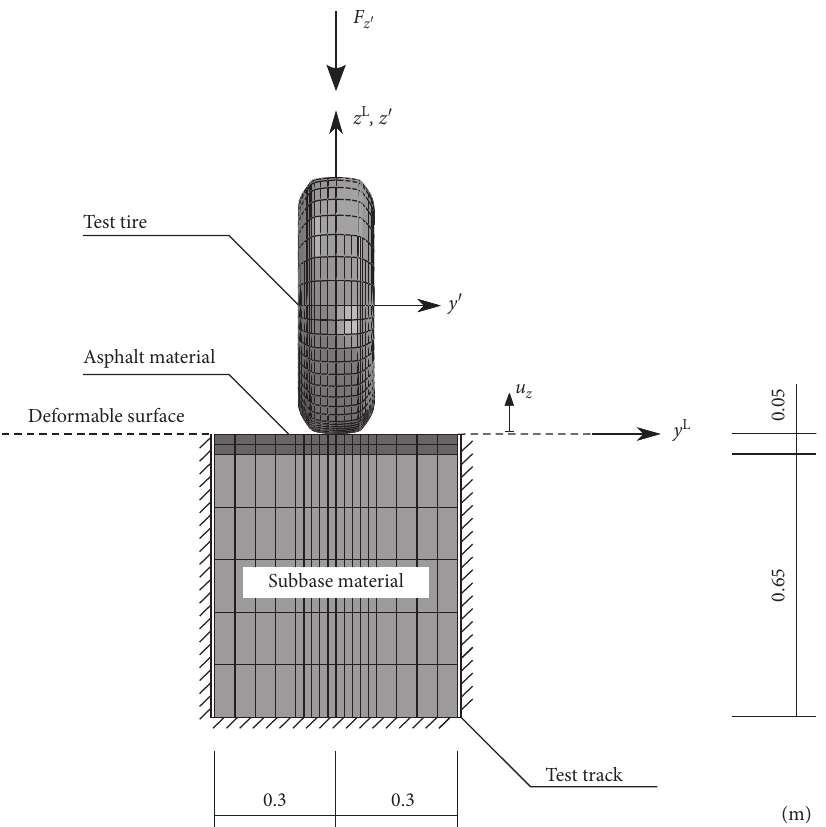
Figure 5: Geometry and FE discretization of the benchmark example (cross section of the near field: thin asphalt layer on subbase material of the test track, both with elastoplastic material behavior) and FE model of the test tire